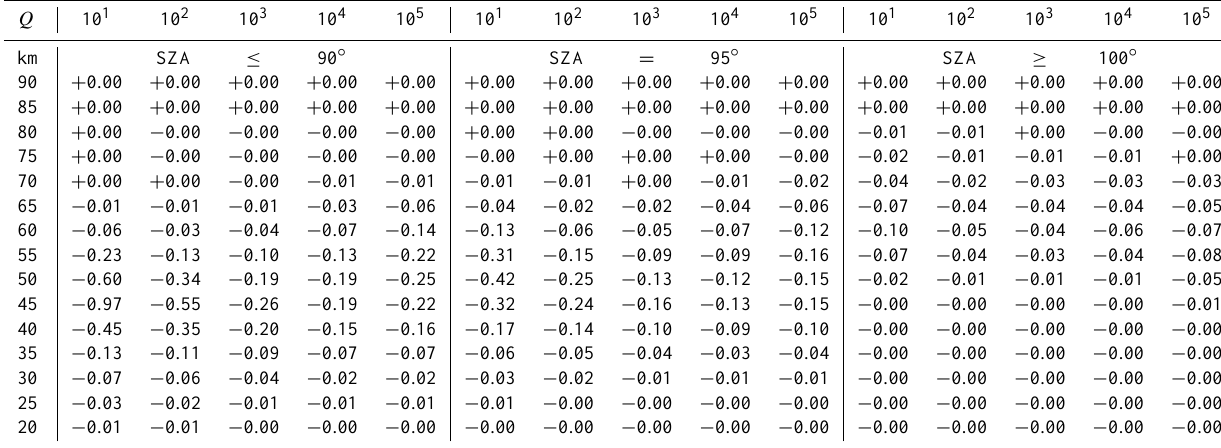
Table A13. P NO /Q for January NH.